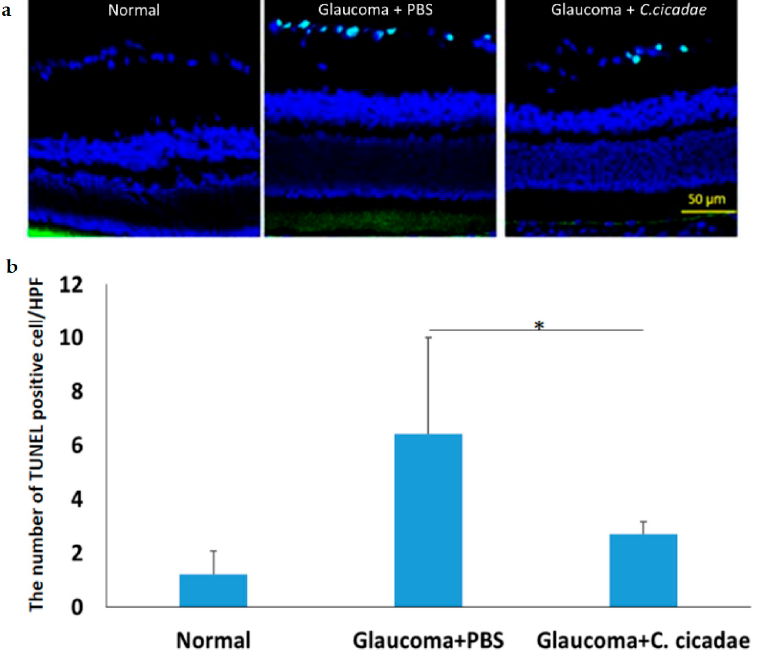
Figure 2. The apoptosis of retinal ganglion cells (RGCs) of rats at day 56. ( a ) Representative terminal deoxynucleotidyl transferase dUTP nick-end labeling (TUNEL) staining of day 56. ( b ) The number of TUNEL-positive cells in the RGC. (mean ± standard error of the mean, SEM; * p < 0.05).